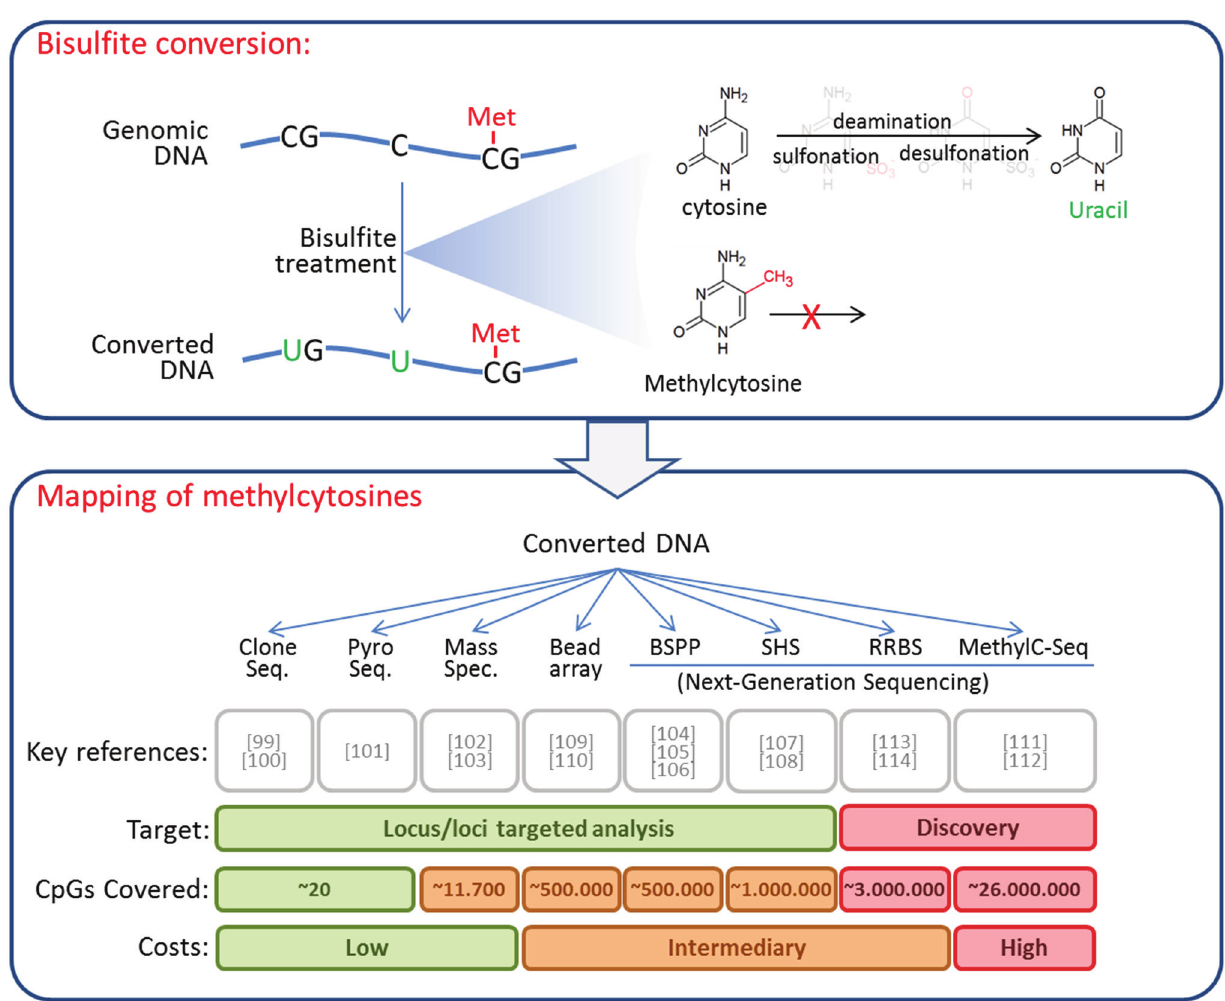
Figure 1. Bisulfite conversion of DNA and methods used for high resolution mapping of methylcytosines. ( Upper panel ) DNA conversion upon treatment with bisulfite. Bisulfite reacts with non-methylated cytosine residues converting them to uracils by initial sulfonation, hydrolytic deamination and final desulfonation. Methylcytosines essentially do not react with bisulfite. After conversion, uracil residues indicate non-methylated cytosines, while cytosines indicate methylcytosines in the original DNA sequence; ( Lower panel ) Converted DNA can be analyzed by multiple techniques discriminating between cytosines and uracils to detect or precisely map methylcytosines. These include clone sequencing (Clone